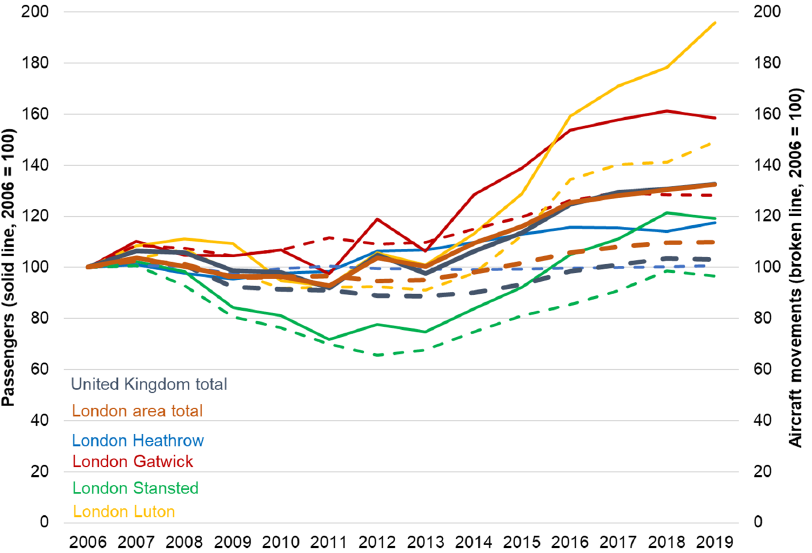
Figure 3. Relative development of passenger volume and aircraft movements at airports in the London area between 2006 and 2019 (2006 = 100) [38], [own illustration].